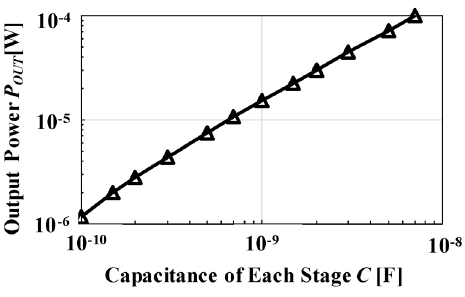
Figure 2. Simulated P OUT as a function of C (AC-DC CP, V DD = 0.5 V, V OUT = 2 V, N = 9, f IN = 1 kHz).